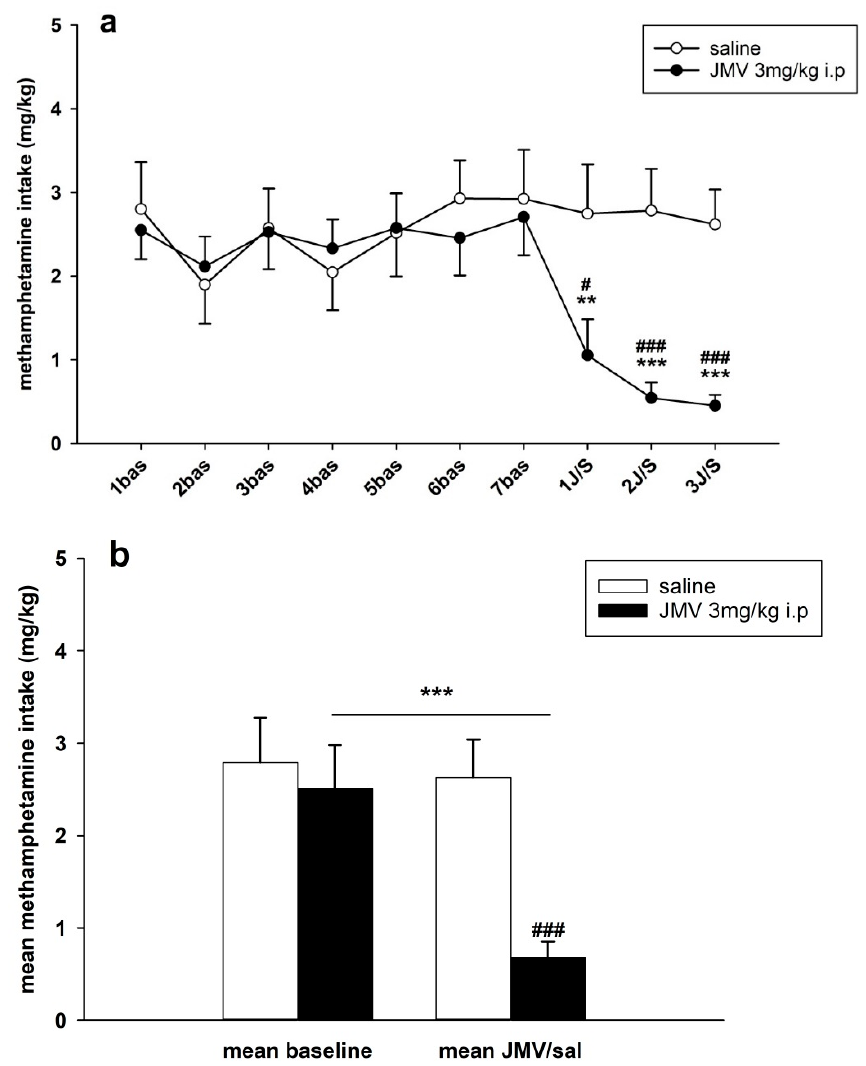
Figure 8. JMV2959 pretreatment effects on methamphetamine consumption/dose mg/kg during